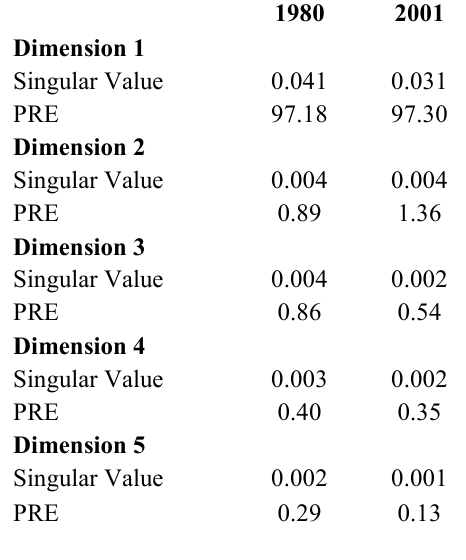
Table 5: Explained Variance of Regular Equivalence Matrix with First Five Dimensions of Correspondence